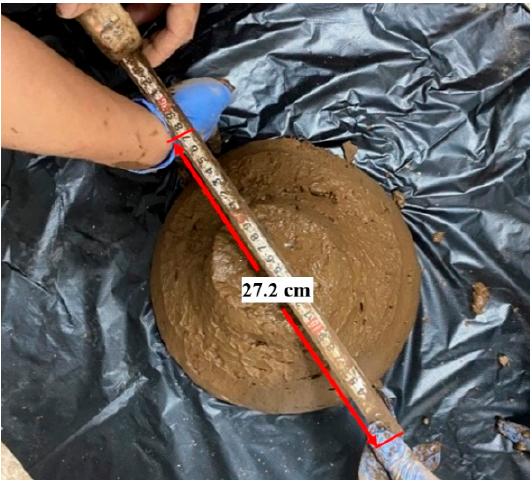
Figure 3. Measurement of slurry expansion with a mass fraction of 64%.